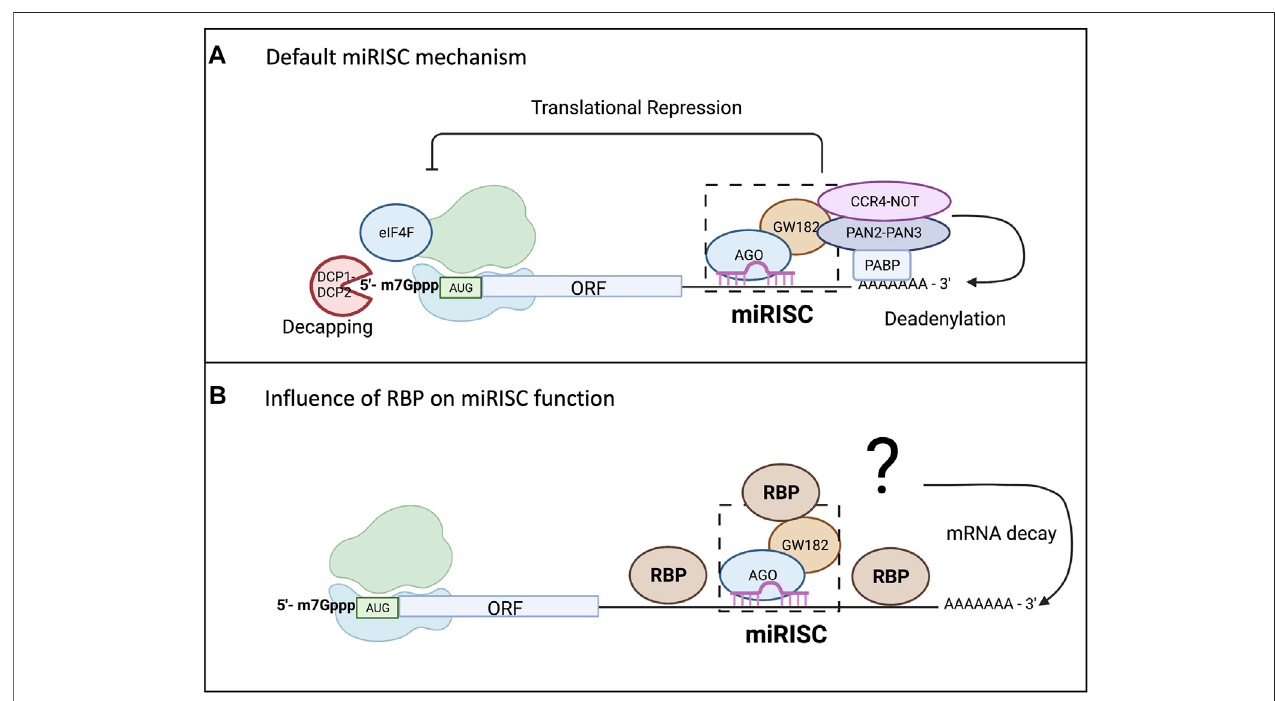
FIGURE 2 | miRISC-mediated gene repression and the in fl uence from RBPs. While there are con fl icting models of miRISC-mediated gene silencing that are not mutuallyexclusive,scientistshaveagreedupona “ default ” mechanismasalltheproposedmechanismsformiRNA-mediatedrepressioninvolverepressionoftranslation and mRNA decay. As shown in (A) , Ago interacts with the PABP complex to promote mRNA deadenylation through recruitment of poly(A) nuclease deadenylation complex subunit 2 (PAN2)-PAN3 and carbon catabolite repressor protein 4 (CCR4)-NOT. Deadenylation promotes decapping by the mRNA-decapping enzyme subunit DCP1-DCP2, making the mRNA vulnerable to degradation by exoribonuclease 1 (XRN1). (B) Highlights the in fl uence RBP binding in the 3 ′ UTR can have on miRISC-mediated gene repression. The RBP can bind up or downstream of the miRISC and either enhance the repression, usually through increasing mRNA degradation, or it could reduce the silencing ef fi ciency of the